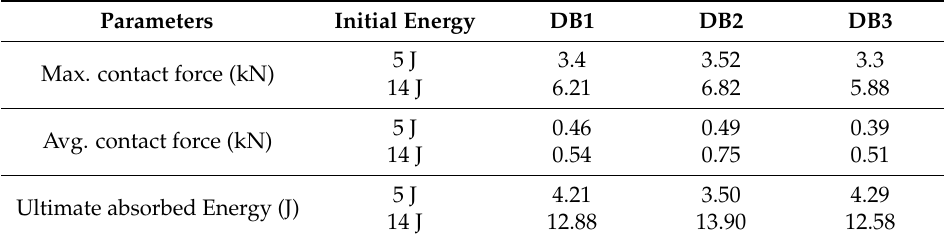
Table 6. The impact parameters of the DB1/DB2/DB3 specimens under the two impact